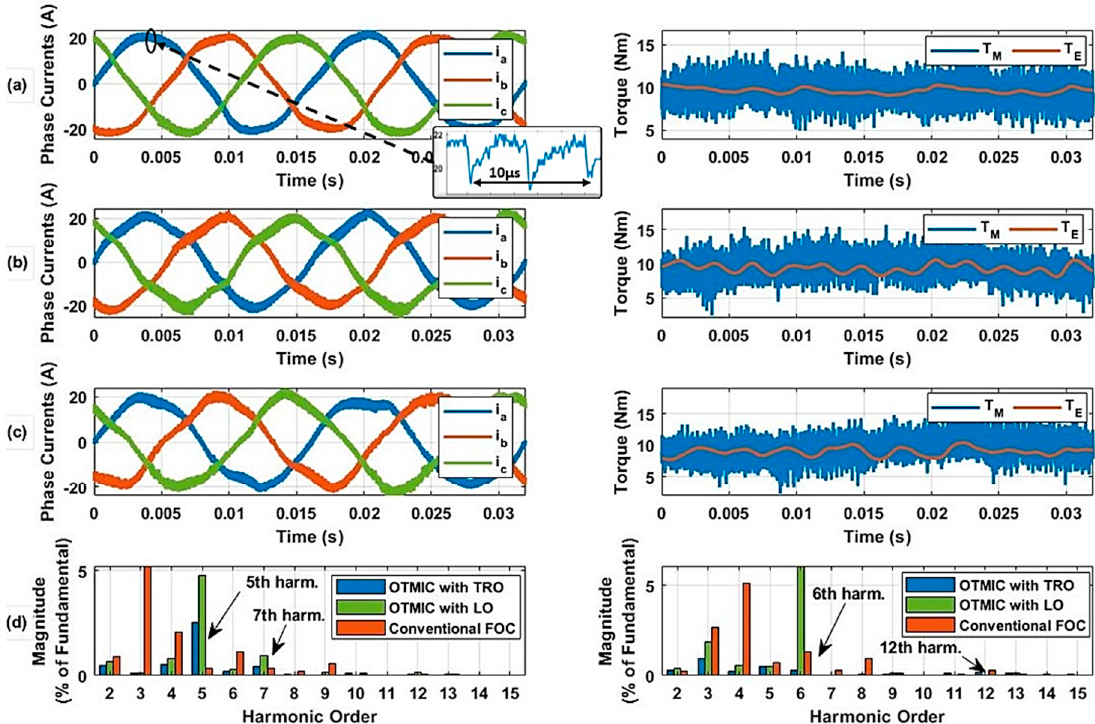
Figure 9. Experimental results of stator current and torque of: ( a ) OTMIC with torque ripples optimization, ( b ) OTMIC with losses optimization, ( c ) conventional DQ control and ( d ) harmonic spectrum of phase current (left) and torque (right) for every method [18].